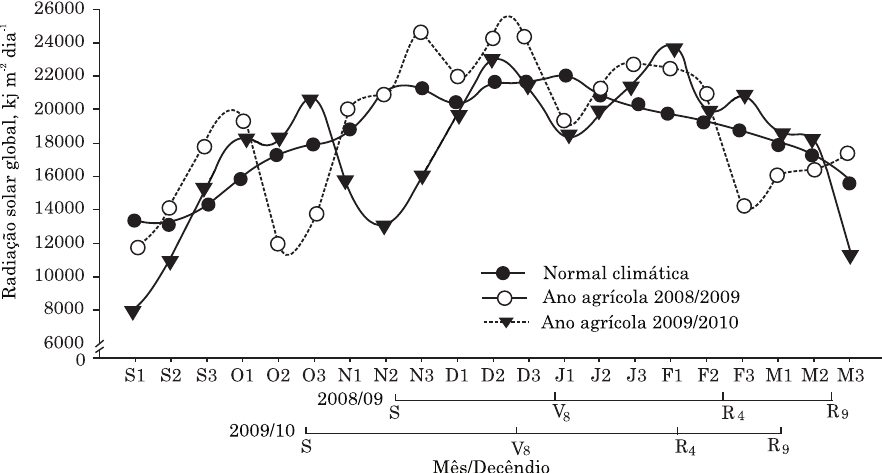
Figura 1. Radiação solar por decêndio nos meses de setembro a março, referente aos anos agrícolas 2008/09 e 2009/10 e à média do período de 1975 a 2002. Fonte: Cargnelutti Filho et al. (2004) e INMET (2012). Legenda: S: semeadura; V 8 : colar formado na oitava folha do colmo principal; R 4 : antese; e R 9 : maturidade completa dos grãos na panícula, conforme Counce et al.